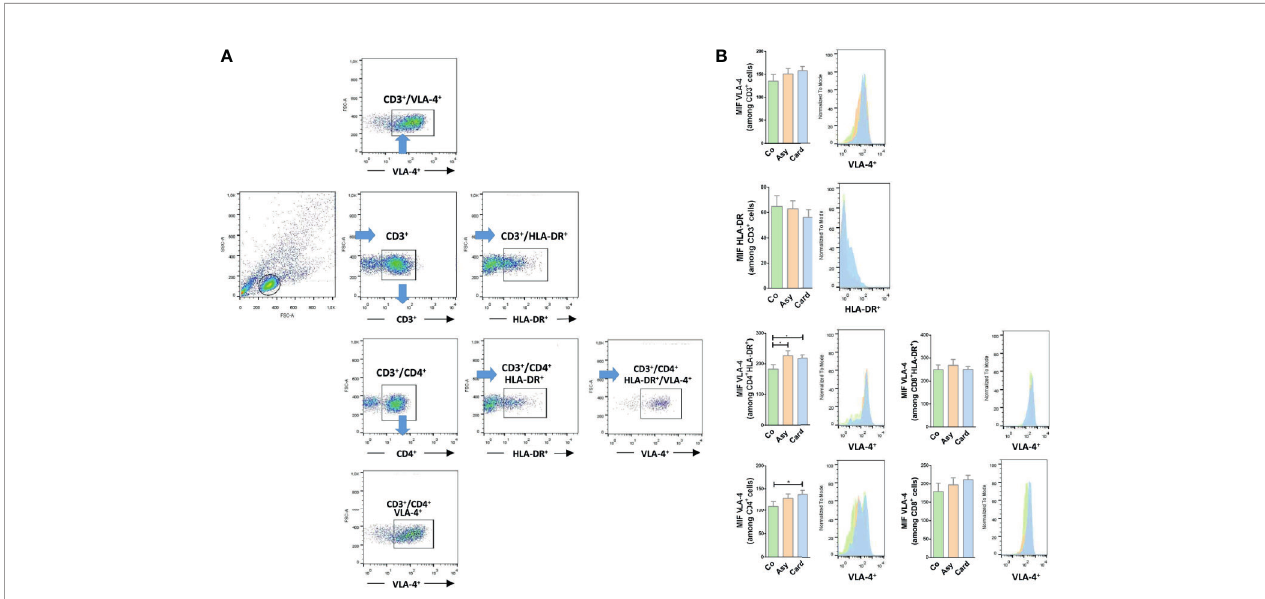
FIGURE 2 | VLA-4 and HLA-DR surface expression in T lymphocytes from chronically T. cruzi – infected individuals. (A) Gating strategy for fl ow cytometry analysis. Cells were fi rst gated on SSC-A versus FSC-A. The lymphocyte gate thus obtained was further analyzed to determine T cell proportions and their expression of HLA- DR and VLA-4 expression. (B) The median fl uorescence intensity (MFI) of HLA-DR and VLA-4 were also evaluated in each subpopulation. *p < 0.05 versus Controls. Kruskal-Wallis followed by Mann-Whitney U test were used for statistical analyses. Co, Control (n = 20); Asy, Asymptomatic (n = 20); Card, Cardiac (n = 26).